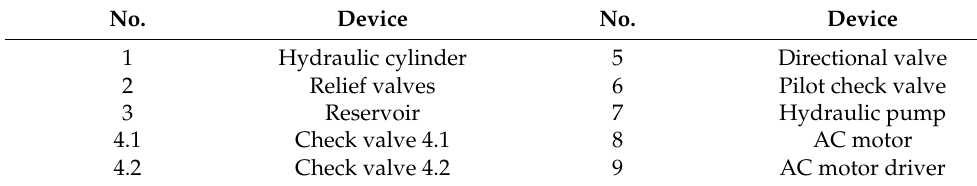
Figure 7. Schematic diagram of the studied EHA system. Table 2. Major components in the considered EHA system.